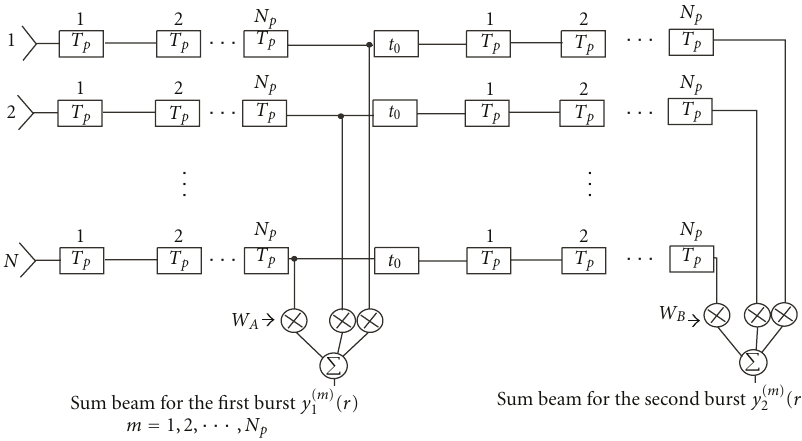
Figure 2: N -Channel receiver configuration with two pulse